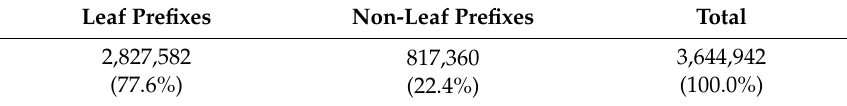
Table 1. The number of prefixes in the FIB which was used in the